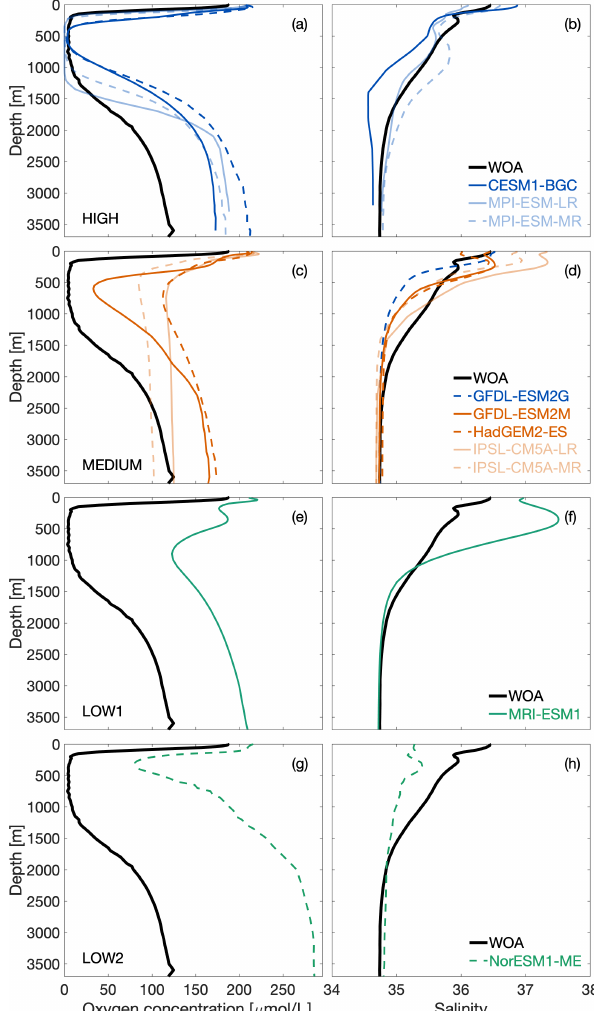
Figure 5. Averaged vertical oxygen (left) and salinity (right) pro- files in the box between 16–22 ◦ N and 61–67 ◦ E (see Fig. 1) in the Arabian Sea for CMIP5 models (coloured) and observational data (black). Blue-coloured models belong to oxygen cluster HIGH (a– b) , red to cluster MEDIUM (c–d) , and green to clusters LOW1 (e– f) and LOW2 (g–h)